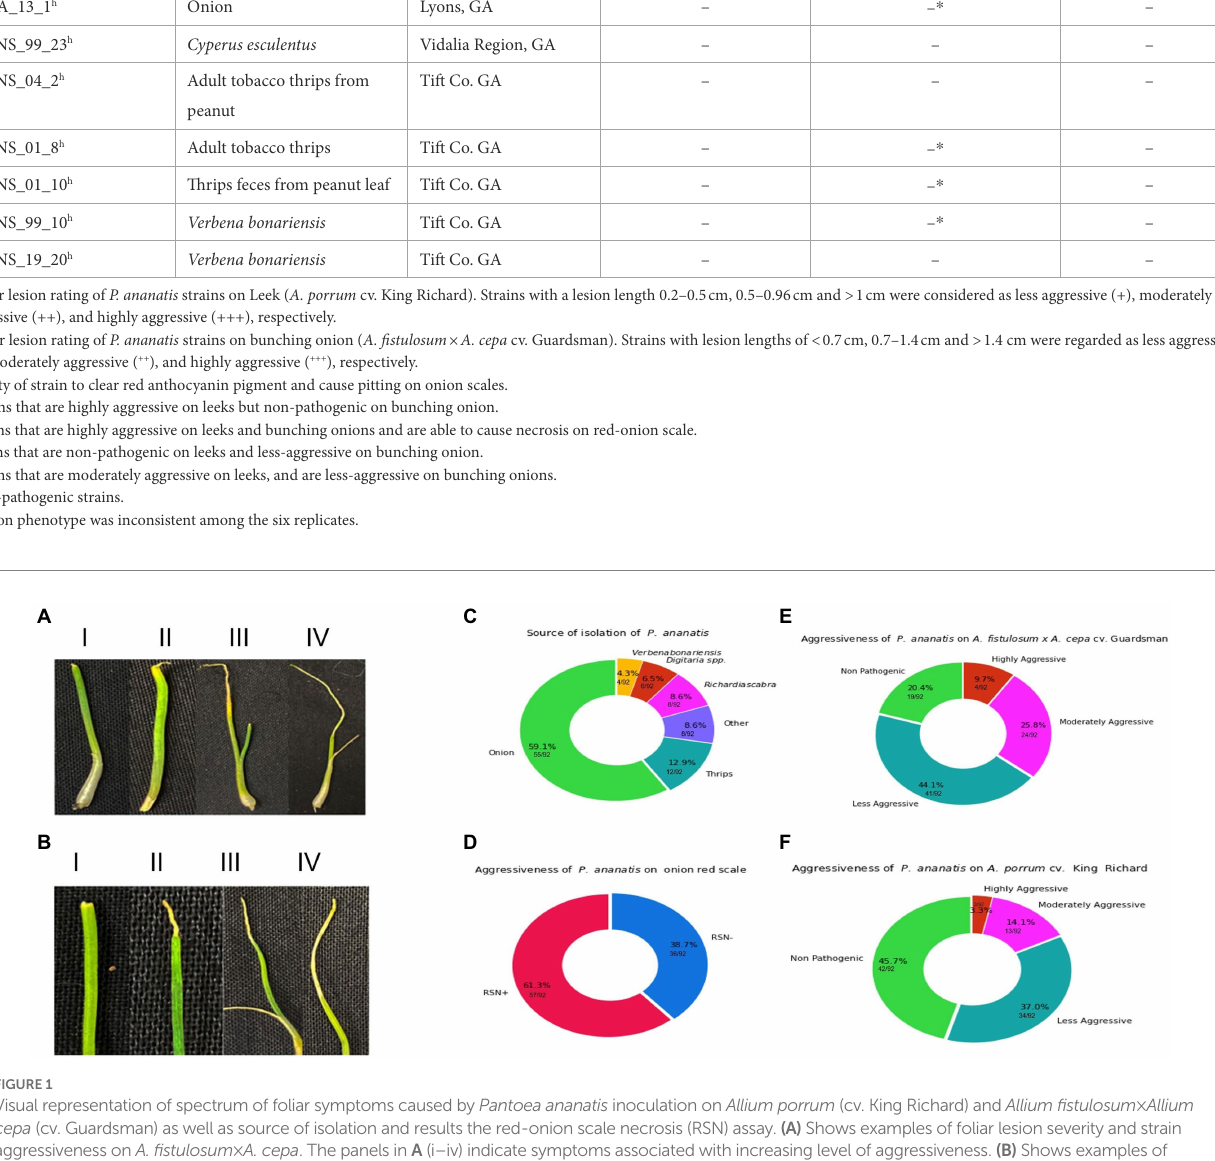
were used as negative control. Three replications per strain per host were used for one experiment and a total of two independent experiments was conducted. The seedlings were observed daily for symptom development until 5 days post-inoculation (DPI) and were compared with the foliar symptoms displayed by the positive control on each Allium species. The aggressiveness of P. ananatis strains was determined based on the lesion length on each Allium spp. For A. porrum , strains that caused a lesion length of 0.2–0.5 cm were considered less aggressive,